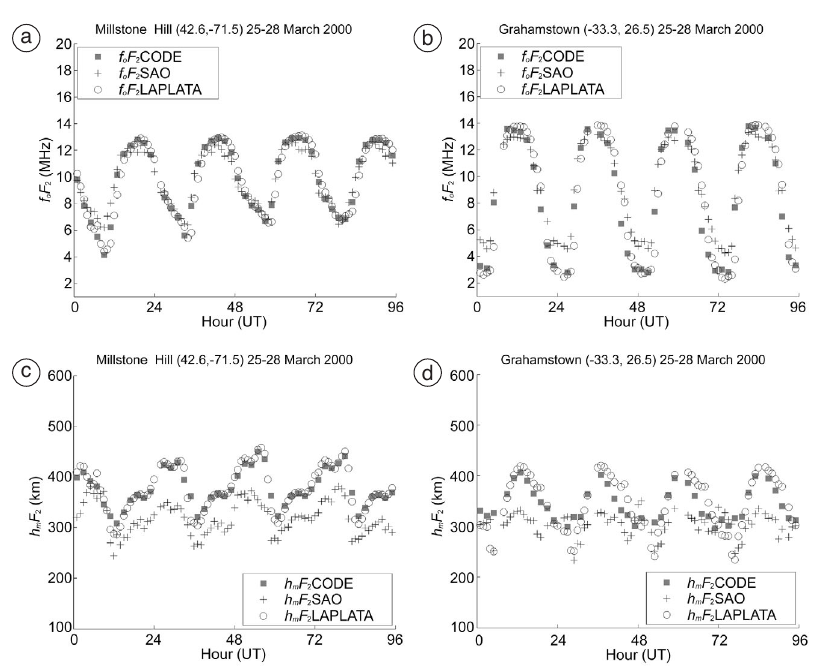
Fig. 2a-d. f o F 2 (a) and h m F 2 (c) for Millstone Hill (middle latitude Northern Hemisphere); f o F 2 (b) and h m F 2 (d) for Grahamstown (middle latitude Southern Hemisphere), during March 2000 (quiet